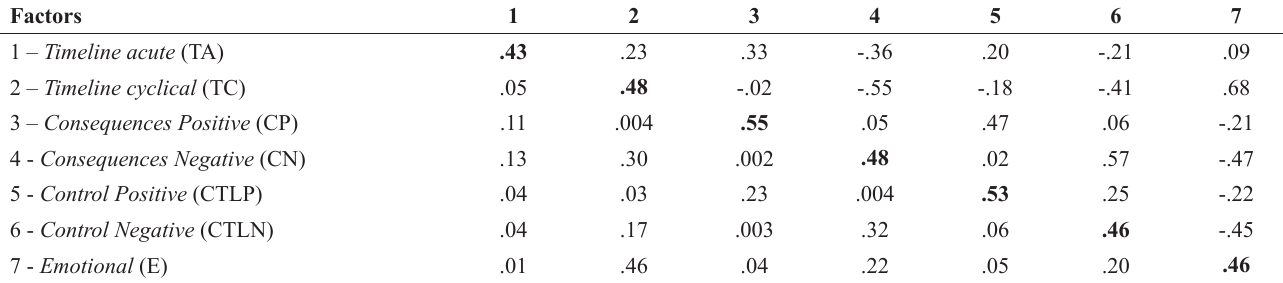
Table 2. Average variance extracted vs. shared variance on the Brazilian